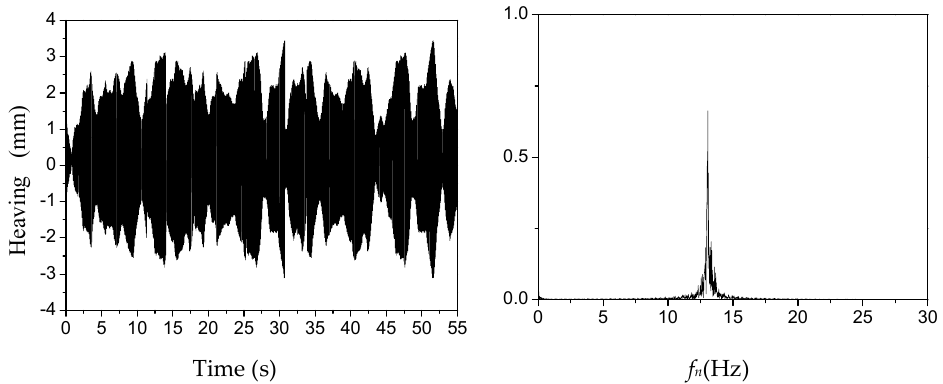
Figure 8. Heaving mode oscillation details (U = 7.8 m / s, U / f 0 D = 7.4) of the two-dimensional (2D) section